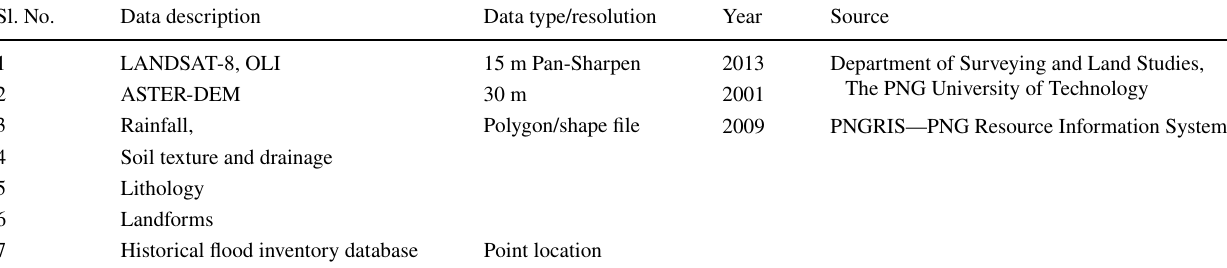
Table 1 Data sets used for flood vulnerability mapping Sl.